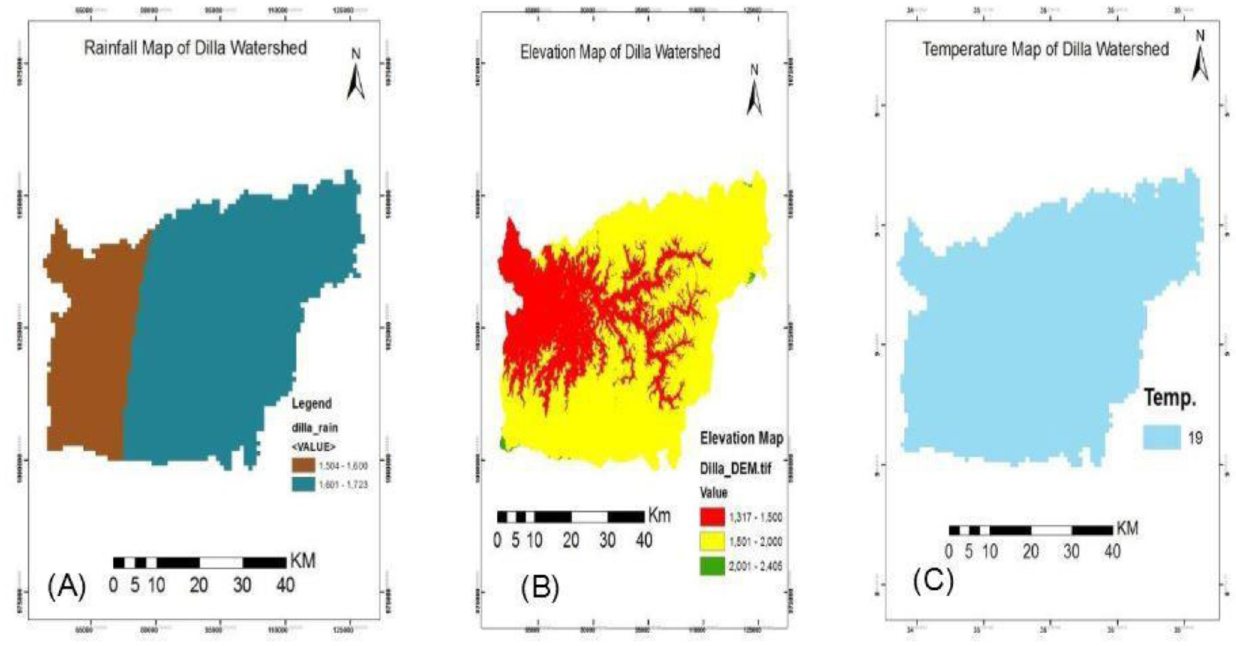
Fig 3. Rainfall, Elevation, and Temperature Based Malaria Risk Area of Dilla Watershed (left to right). Source: Ethiopian Central Statistical Agency.